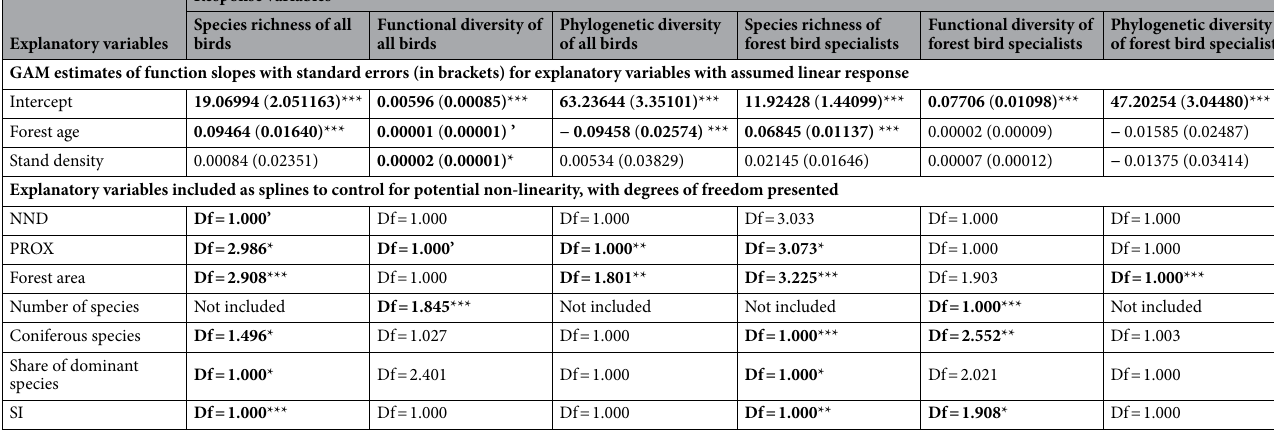
Table 2. The effect of environmental variables on bird diversity components at patch characteristics and isolation metrics. Statistically significant effects are emboldened: ***P < 0.001, **P < 0.01, *P < 0.05, ‘P <